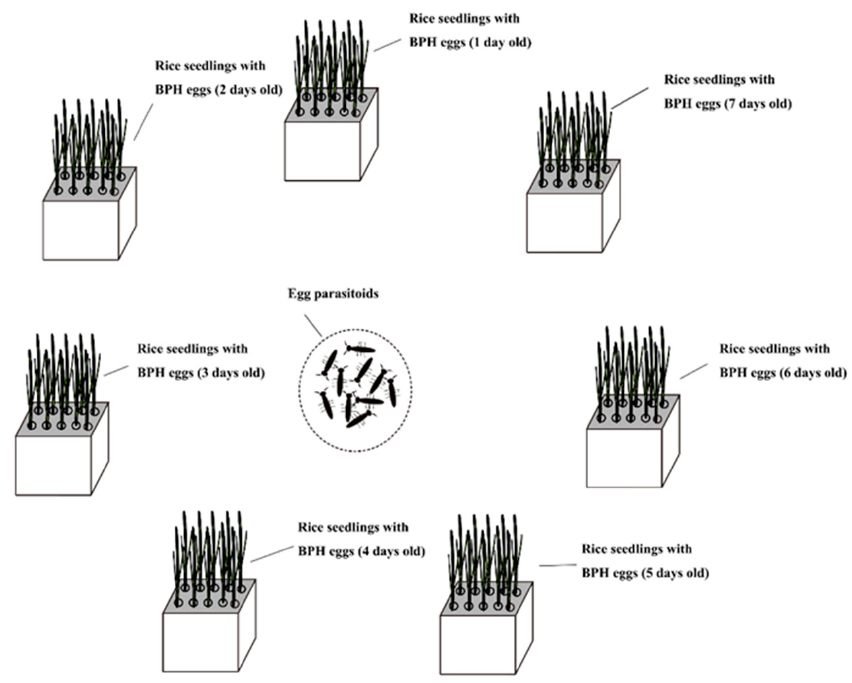
Figure 2. Experimental illustration of the parasitism preference of egg parasitoids among 1–7-days- old BPH eggs.